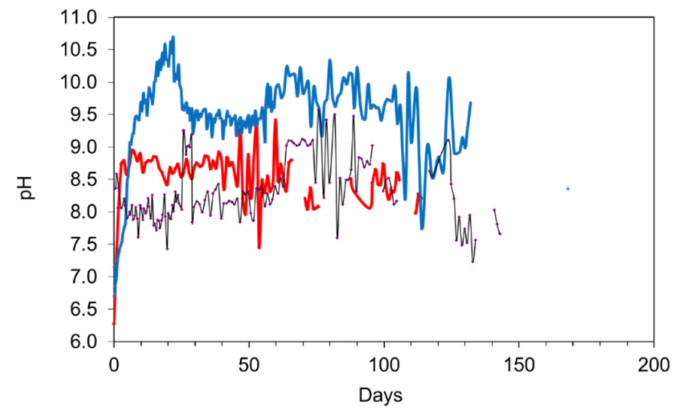
Figure 16. Comparison of three different materials for the desalination of saline water: Salin- ity = 7.52 g L − 1 ; Temperature over the reaction period = 0.2 to 14 ◦ C; water volume = 1 L. Red = De- salination pellet, 18 g L − 1 ; black = 1 g L − 1 n-Fe 0 ; Blue = 25 g L − 1 n-Fe 0 .